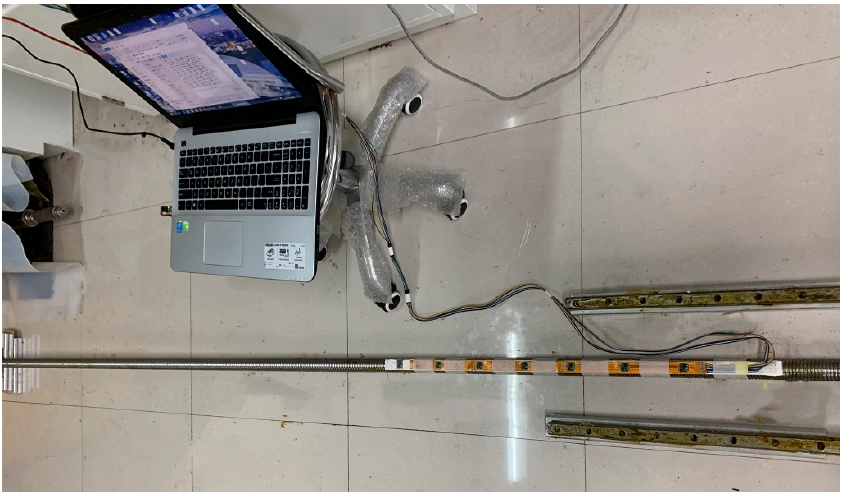
Figure 9. The test of the radial deformation amount of the lead screw.